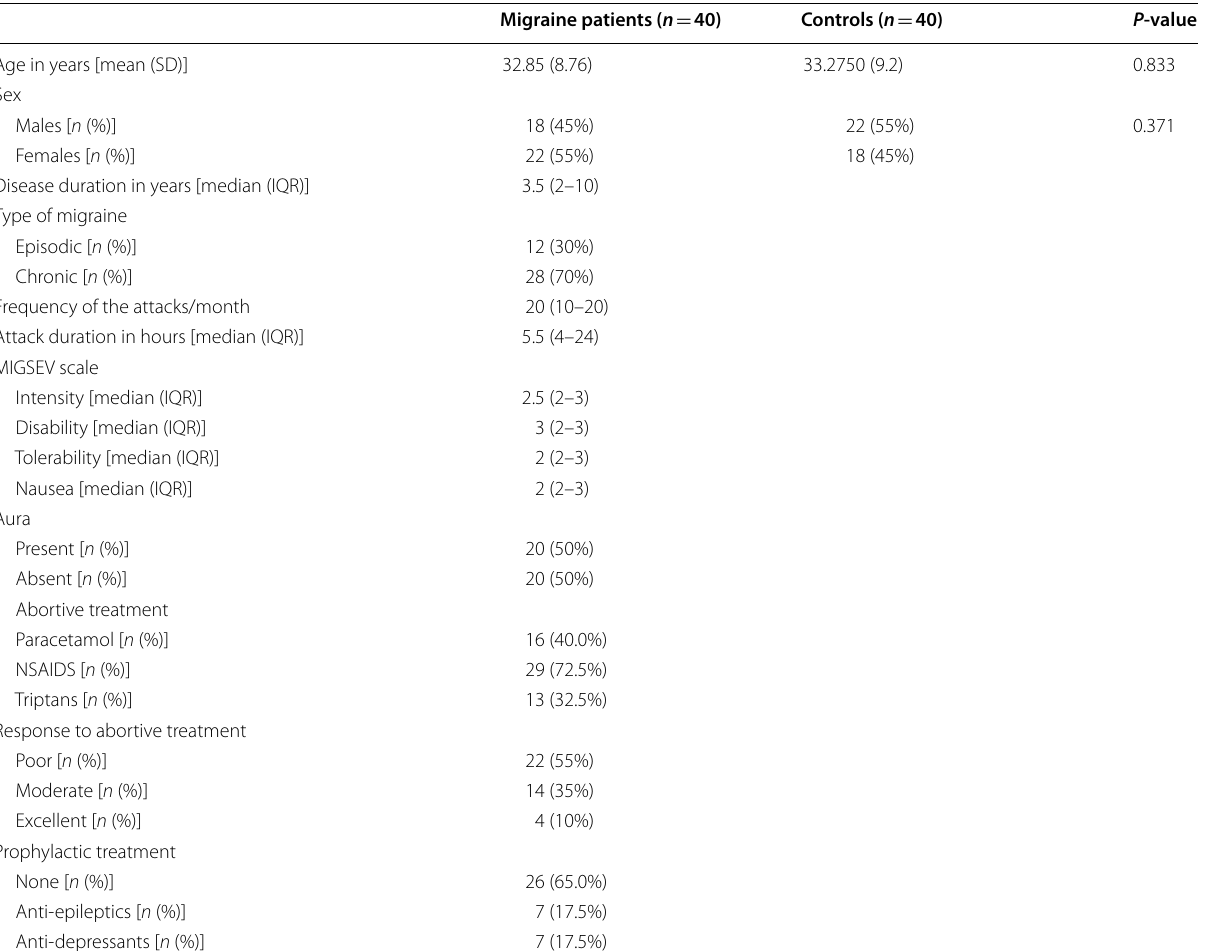
Table 1 Demographics and clinical characteristics of migraine